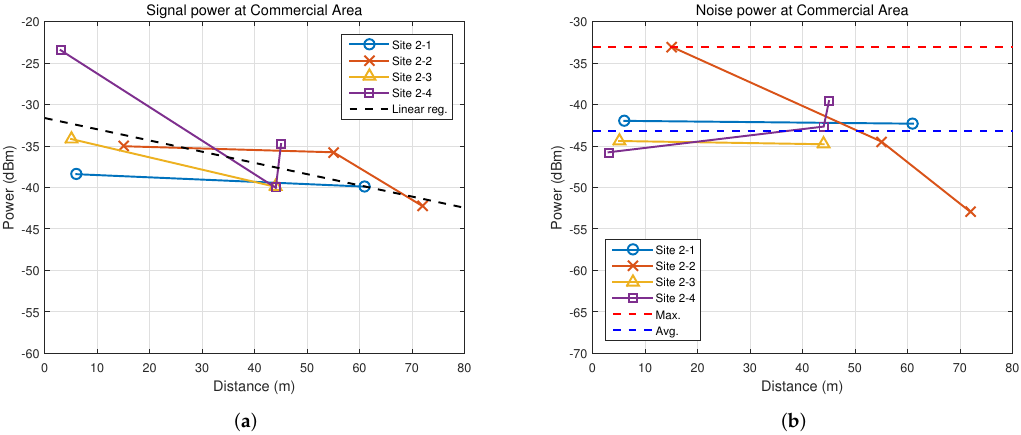
Figure 21. Overhead Commercial Area. ( a ) Received power. ( b ) Noise power.